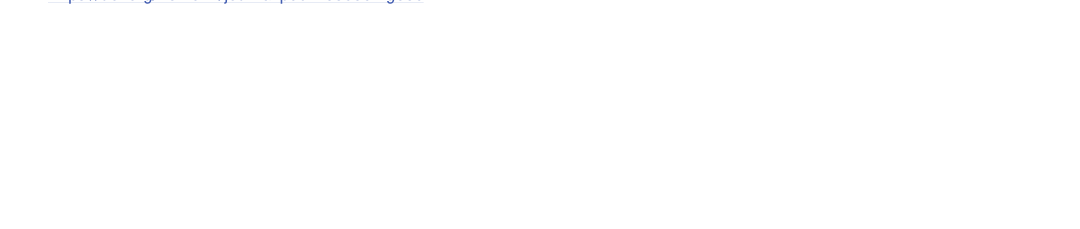
PLOS Computational Biology | https://doi.org/10.1371/journal.pcbi.1008961 May 3,